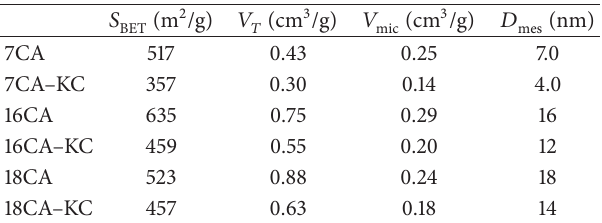
Table 1: Pore parameters of the 𝑥 CA and 𝑥 CA–KC